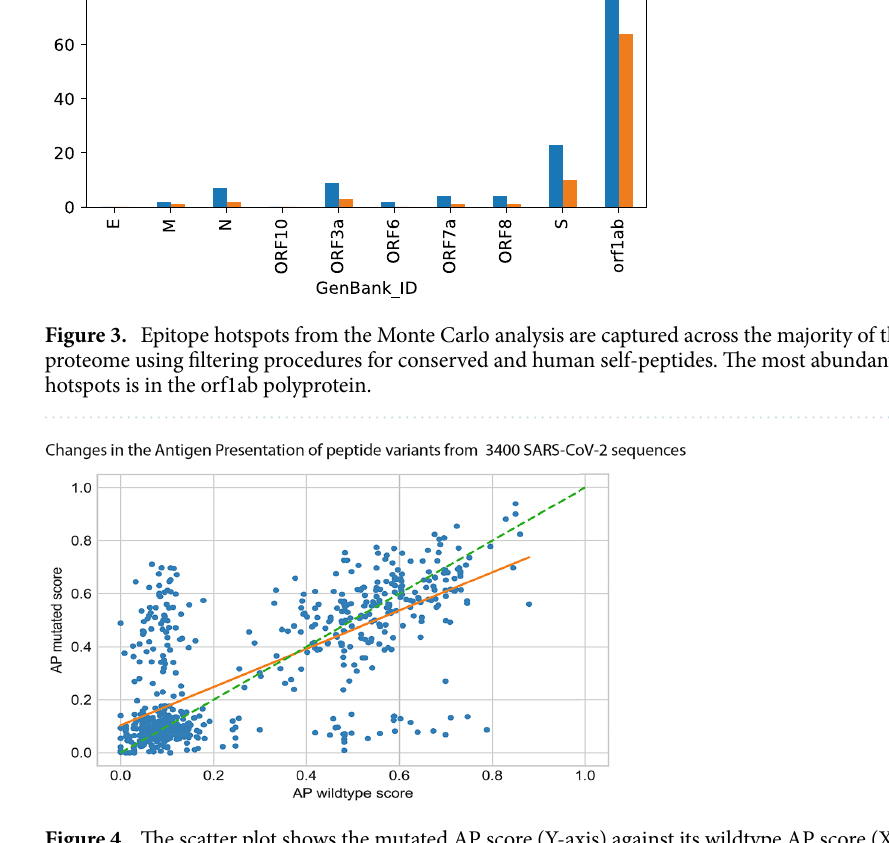
Figure 4. The scatter plot shows the mutated AP score (Y-axis) against its wildtype AP score (X-axis) for each peptide variant. Each data point (blue circles) represents a peptide variant identified in a SARS-COV-2 sequence when comared to the Genbank (Wuhan) reference sequence. There was a total of 1122 peptide variants identified in such a comparison and illustrated on the plot. The orange line is a least square fit with slope = 0.72. Peptide variants on the green dashed line of slope 1 would show no change in AP after introduction of the peptide